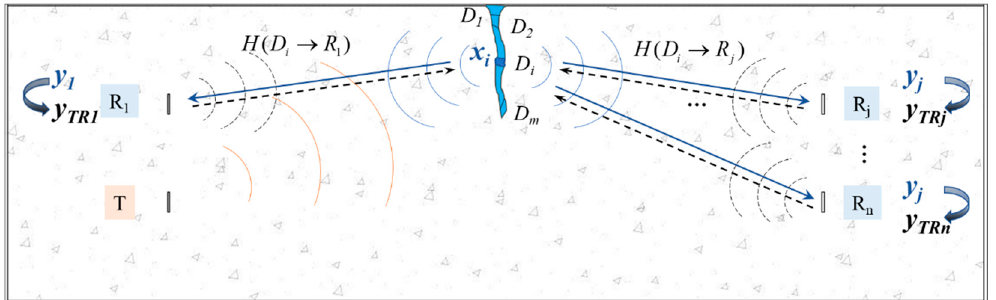
Figure 3. A sketch map of the wave time reversal process.